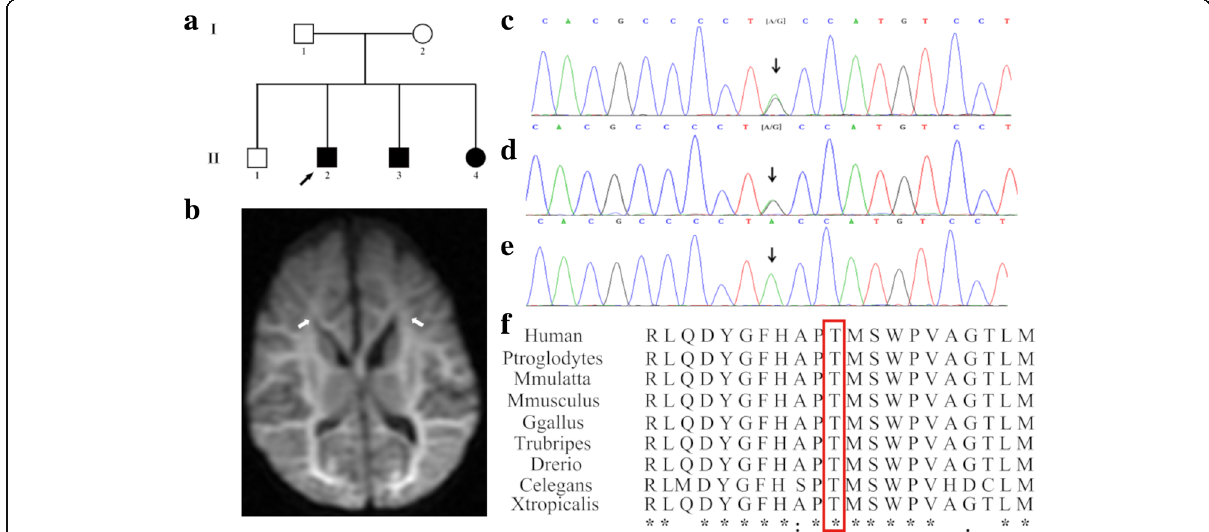
Fig. 1 a Pedigree of the family. The filled black symbols represent the affected members and the arrow denotes the proband. b Diffusion Weight Imaging (DWI) of MRI showed extensive white matter diffusion restriction extending to the subcortical white matter in the proband ’ s younger sister. White matter shows a hyper-intense signal by DWI. c-e Sequence analysis of GLDC gene separately identified the heterozygous c.2680A>G variant in the proband ( c ) and his mother ( d ), but not in his father ( e ). f Amino acid alignment of the P-protein from several organisms. The position of Thr894 residue (highlighted by a red box) was highly conserved among different